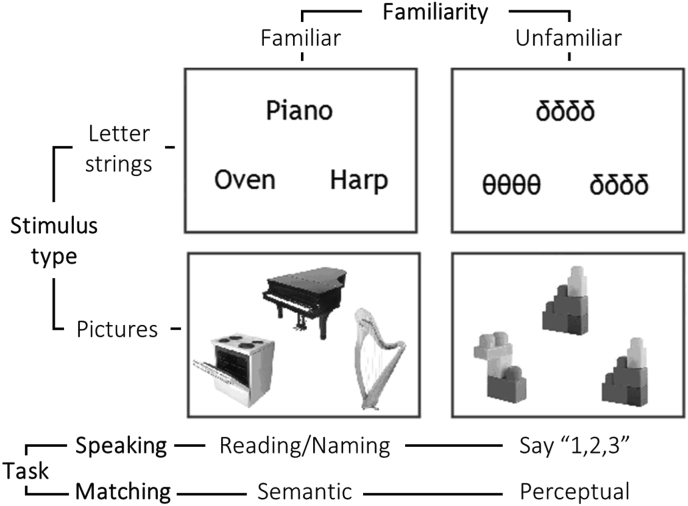
Experimental design. Our experimental paradigm manipulated the factors “stimulus type” (letter strings versus pictures), “familiarity” (familiar words and objects versus unfamiliar Greek letter strings and nonobjects) and “task” (matching versus speaking). In all trials, three stimuli were simultaneously presented as a “triad”, with one stimulus above and two stimuli below. In the matching tasks, participants made a finger press response to make: semantic matching decisions on words and objects (i.e. matching ‘Piano’ to ‘Harp’ rather than ‘Oven’) and perceptual matching decision on the unfamiliar stimuli (based on physical identity). In the speaking tasks, participants read/named aloud familiar words and objects and say “1,2,3” in response to seeing the unfamiliar stimuli.